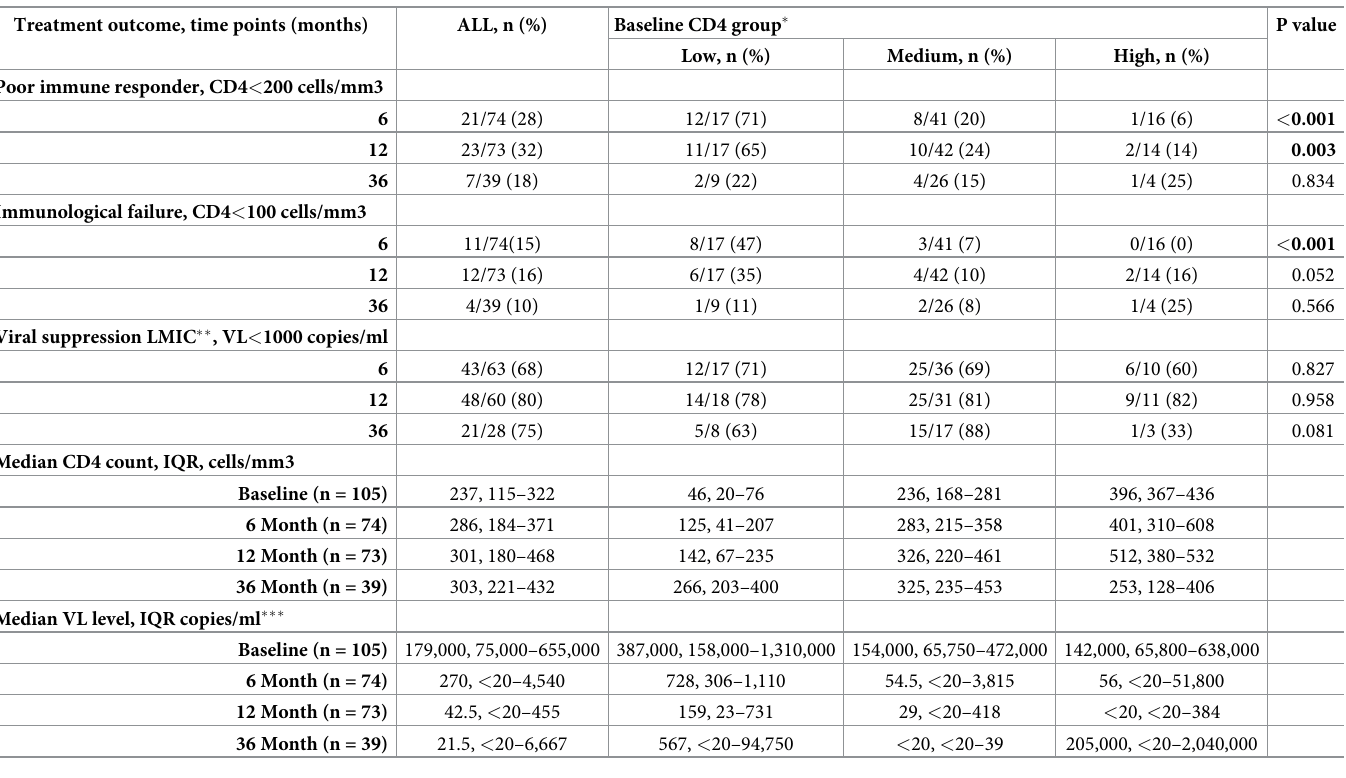
Table 2. Temporal HIV treatment outcomes separated by baseline CD4 groups. Treatment outcome, time points